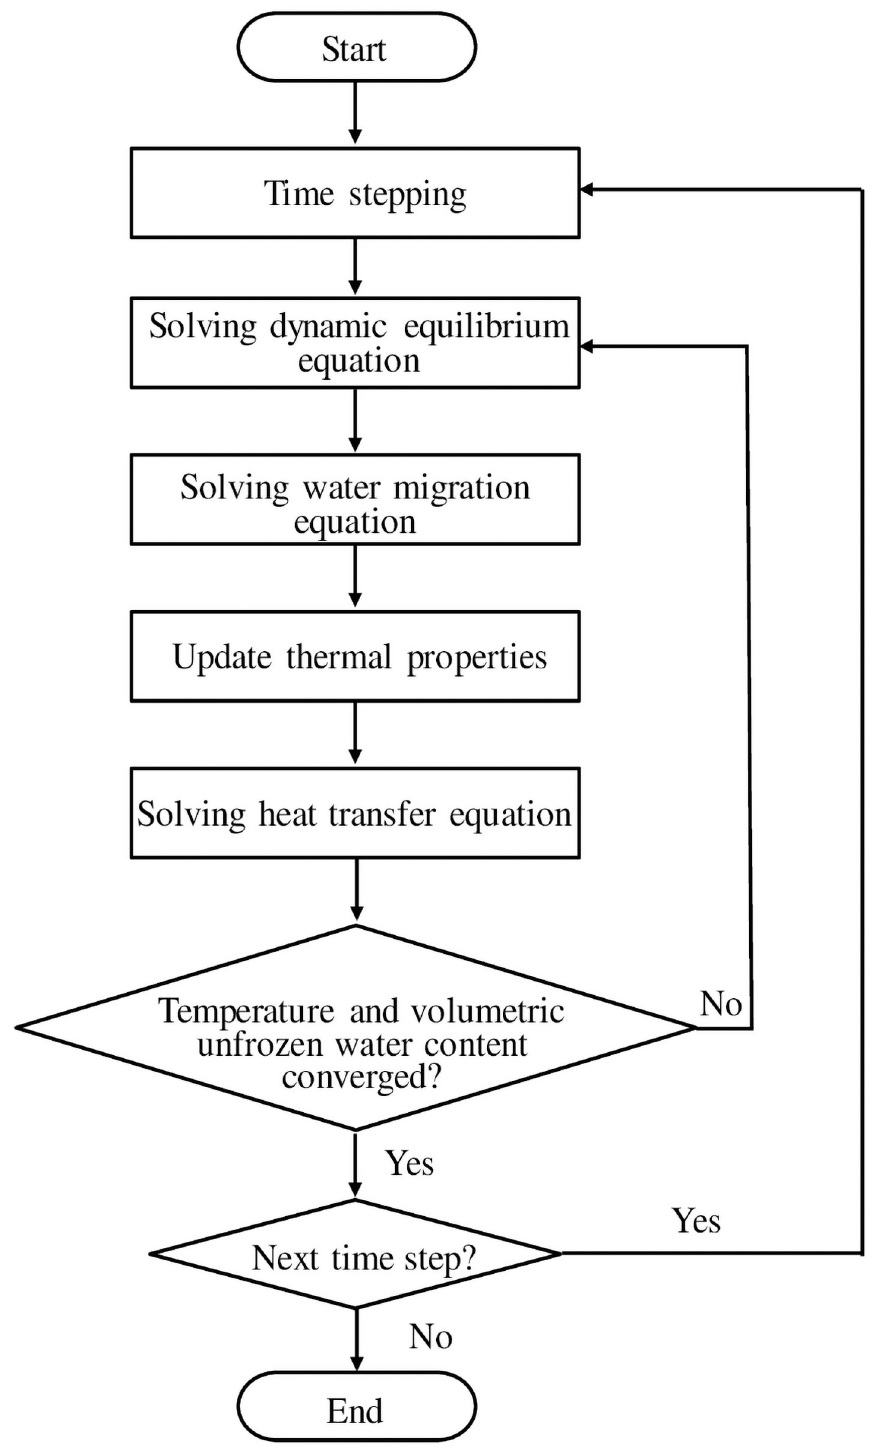
Fig 1. Flowchart of the computational process.